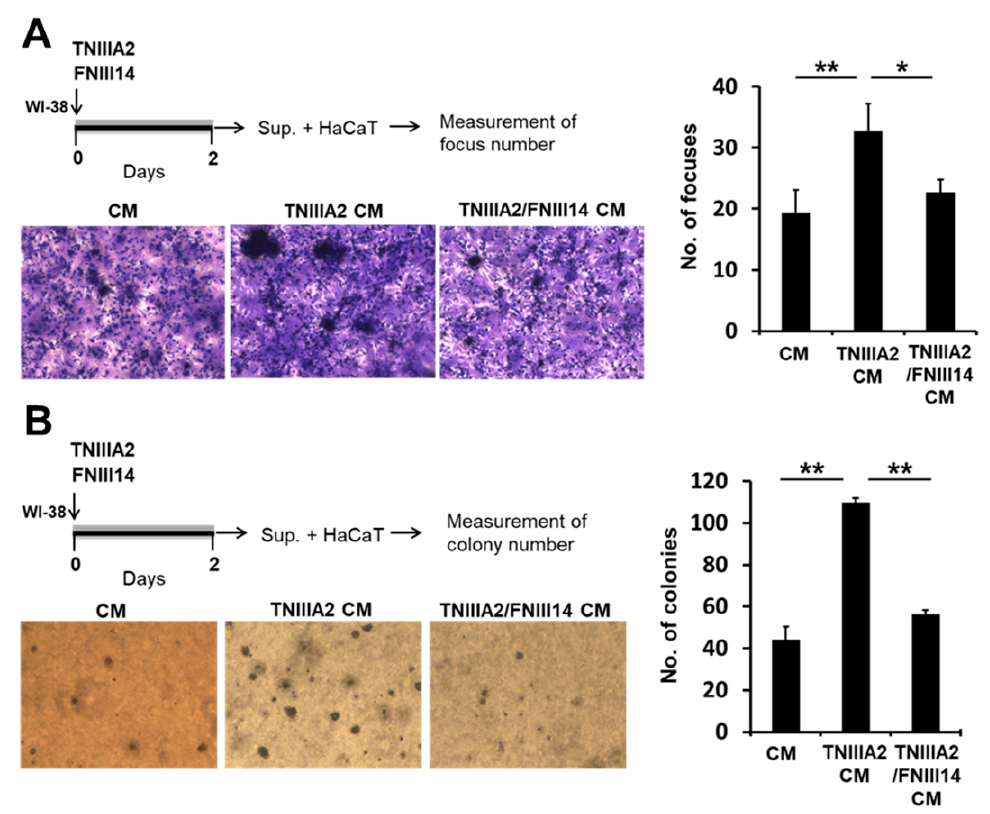
Figure 3. Peptide TNIIIA2-induced malignant progression in preneoplastic epithelial HaCaT cells. Conditioned